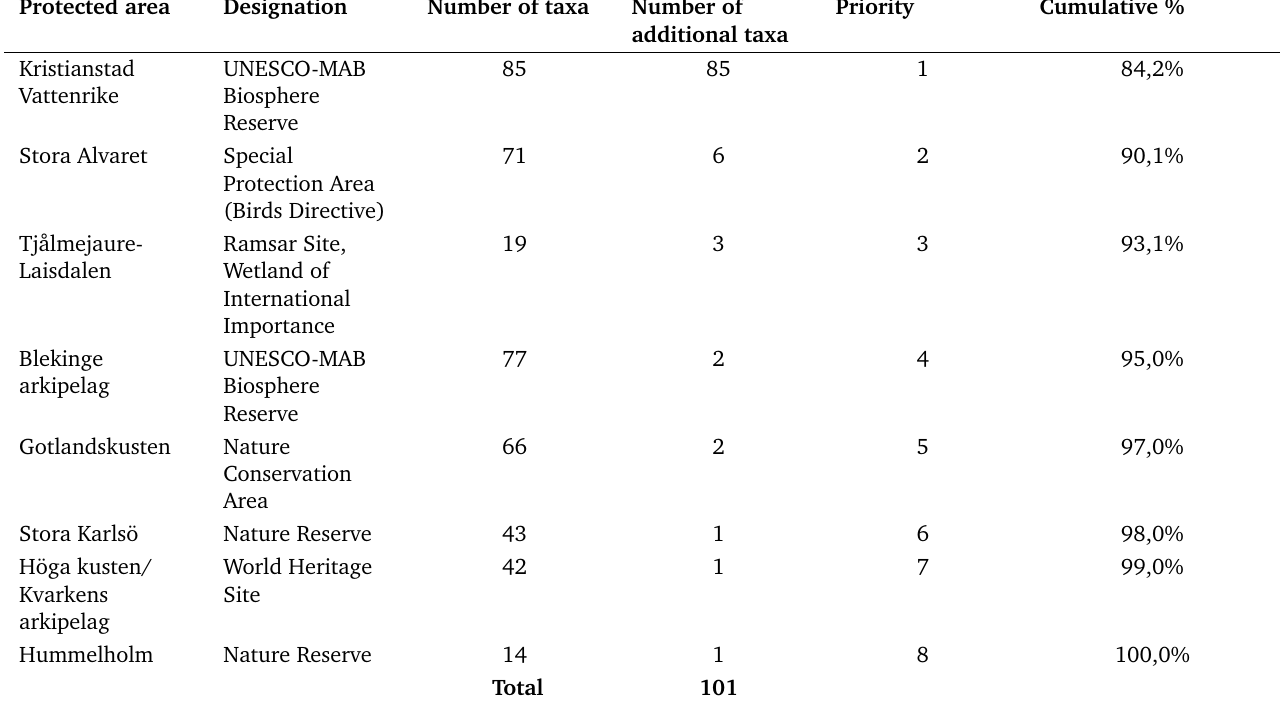
Table 1. Protected Area Complementarity Analysis. The ’number of taxa’ is the total number of different taxa in the protected area. The ’number of additional taxa’ is the number of unique taxa within that protected area (i.e. these taxa are not found in any of the previous protected